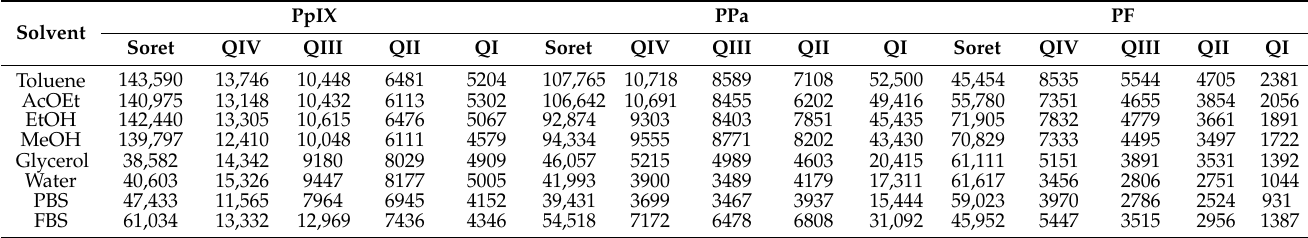
Table 2. Molar extinction coefficient ( ε , (M − 1 · cm − 1 )) of PpIX, PPa, and PF in different solvents at room temperature. PpIX Solvent